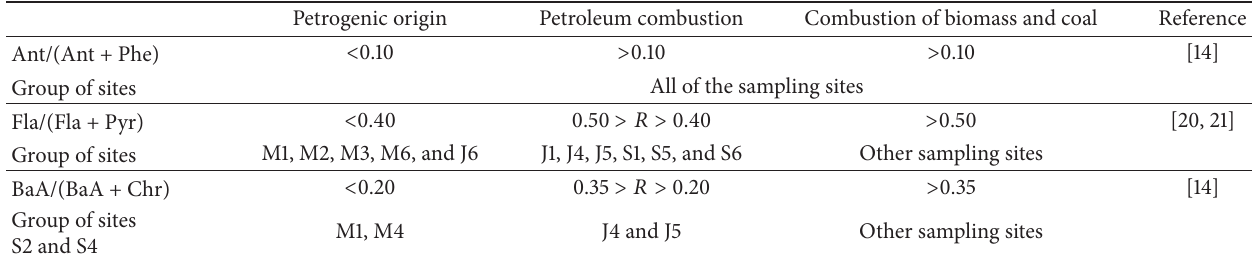
Table 2: The reference standard of PAHs source identification for ratio method.